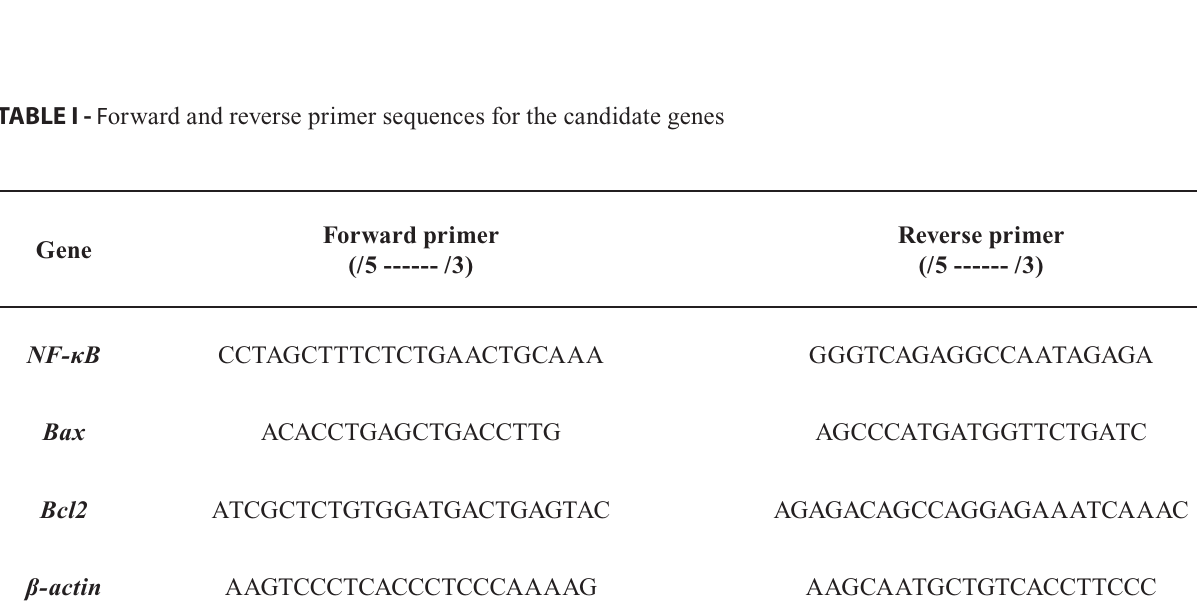
TABLE I - F orward and reverse primer sequences for the candidate genes